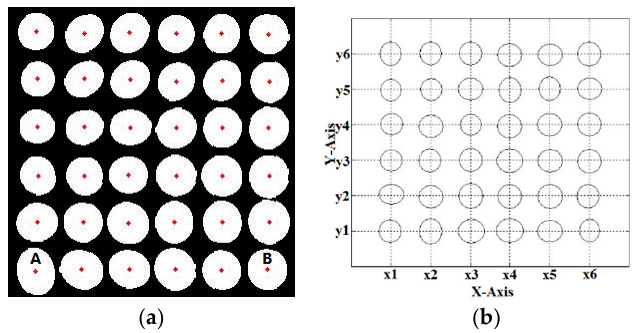
Figure 5. ( a ) extracting centroid coordinates; ( b ) determining the location of center coordinates.